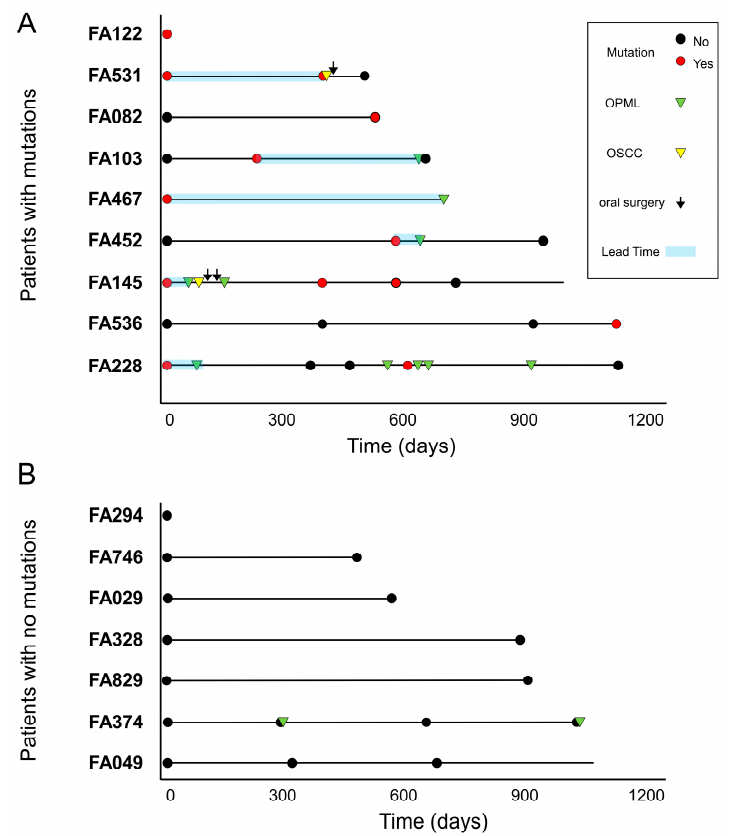
Figure 4. Fanconi anemia patients with mutations develop OPML and/or OSCC. Schematic repre- sentation of the molecular and clinical events during patient’s follow-up. ( A ) A total of 9/16 patients had mutations in at least one liquid biopsy sample, and 6/9 patients had clinical follow-up data after mutations were found; all of them displayed OPML or OSCC afterwards. Time from mutation detec- tion to tumor detection (lead time) is shown (blue boxes). Solid horizontal lines represent clinically informed follow-up times from the first LB analyzed in each patient. ( B ) A total of 7/16 patients displayed no mutations, 6 of whom were free of OPML or OSCC.